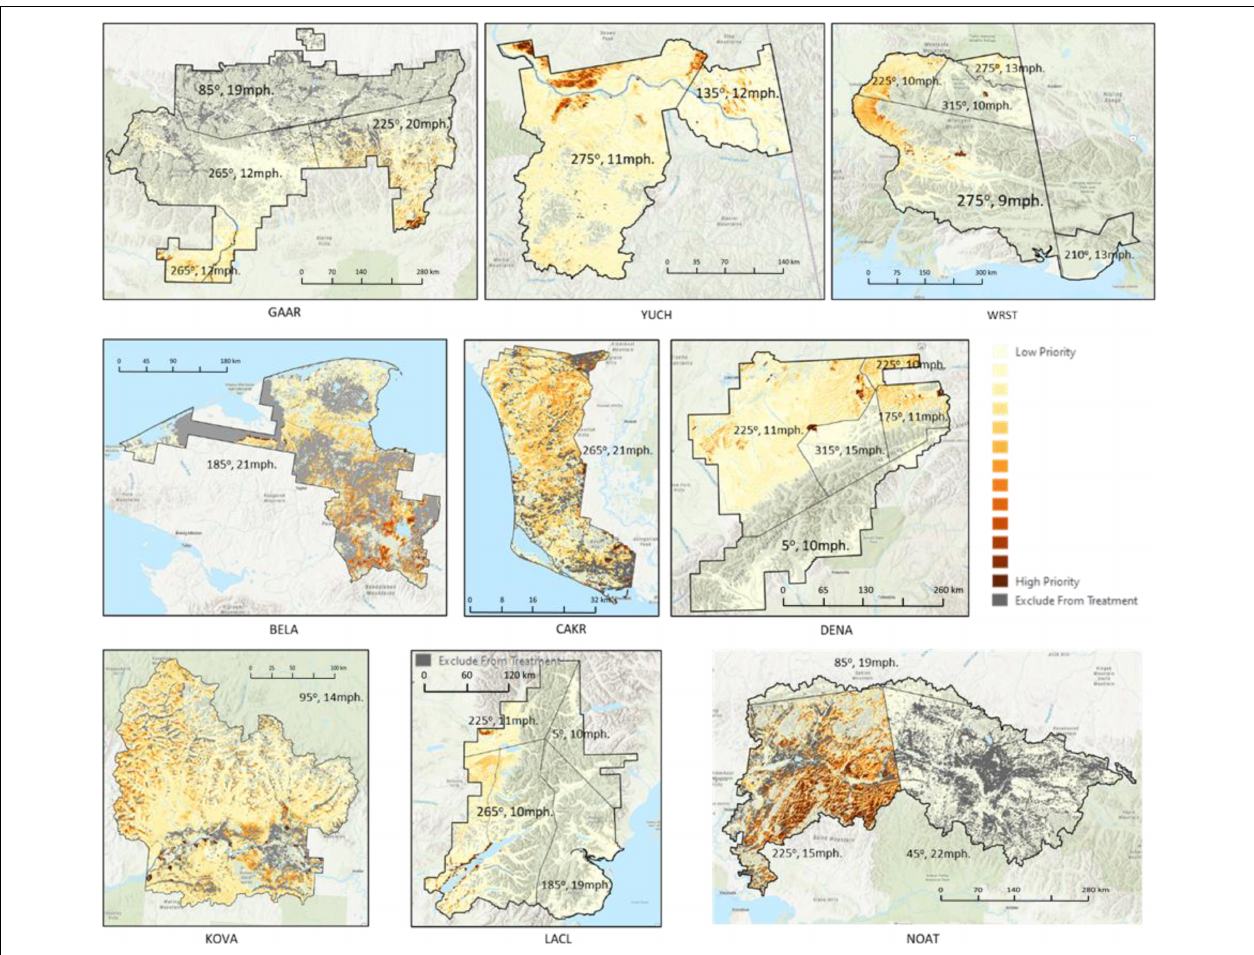
FIGURE 3 | Fuel treatment prioritization for the nine national parks under different simulated fire weather conditions. The wind direction and speed (e.g., 225 degree and 20 miles per hour) used for each management zone were identified by park fire managers.